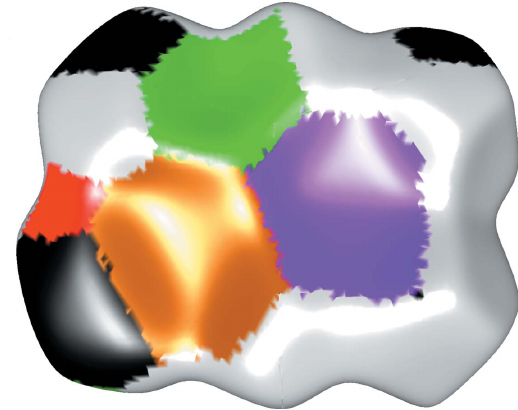
Table 1 Short halogen–halogen distances.